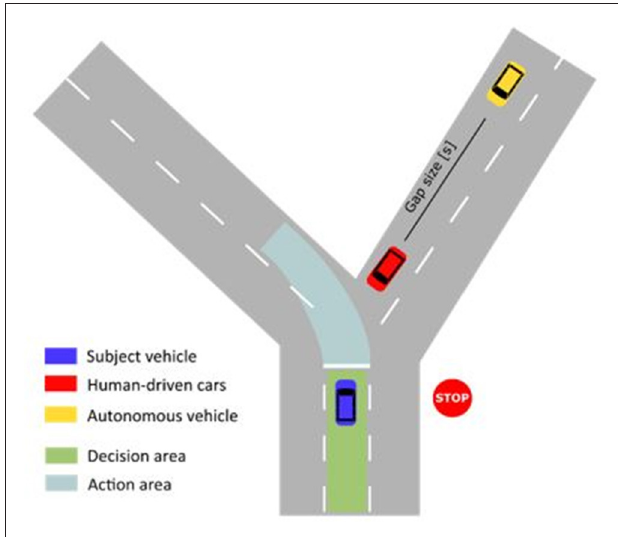
FIGURE 3 | Sketch of intersection. The gap size between two oncoming vehicles defined as the time that passes after the first oncoming vehicle has crossed the intersection until the second vehicle has crossed the